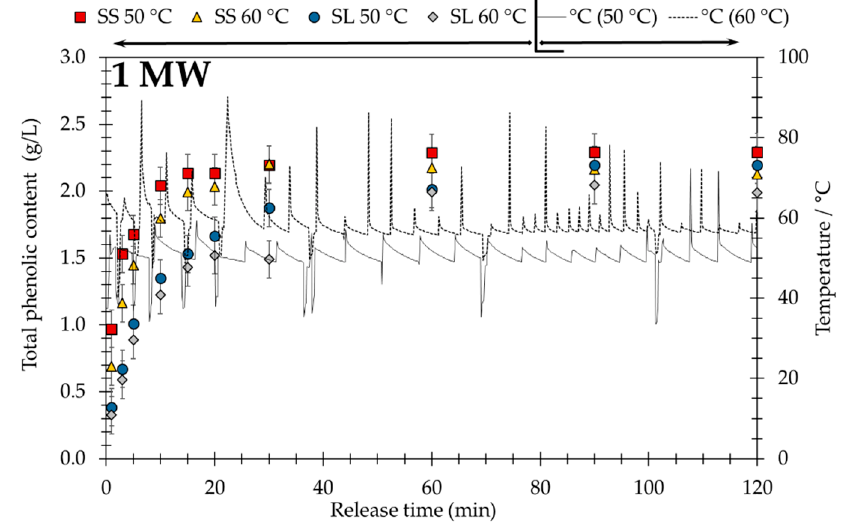
Figure 3. Extraction kinetics (left axis) and measured temperature curves (right axis) using microwaves (MW).